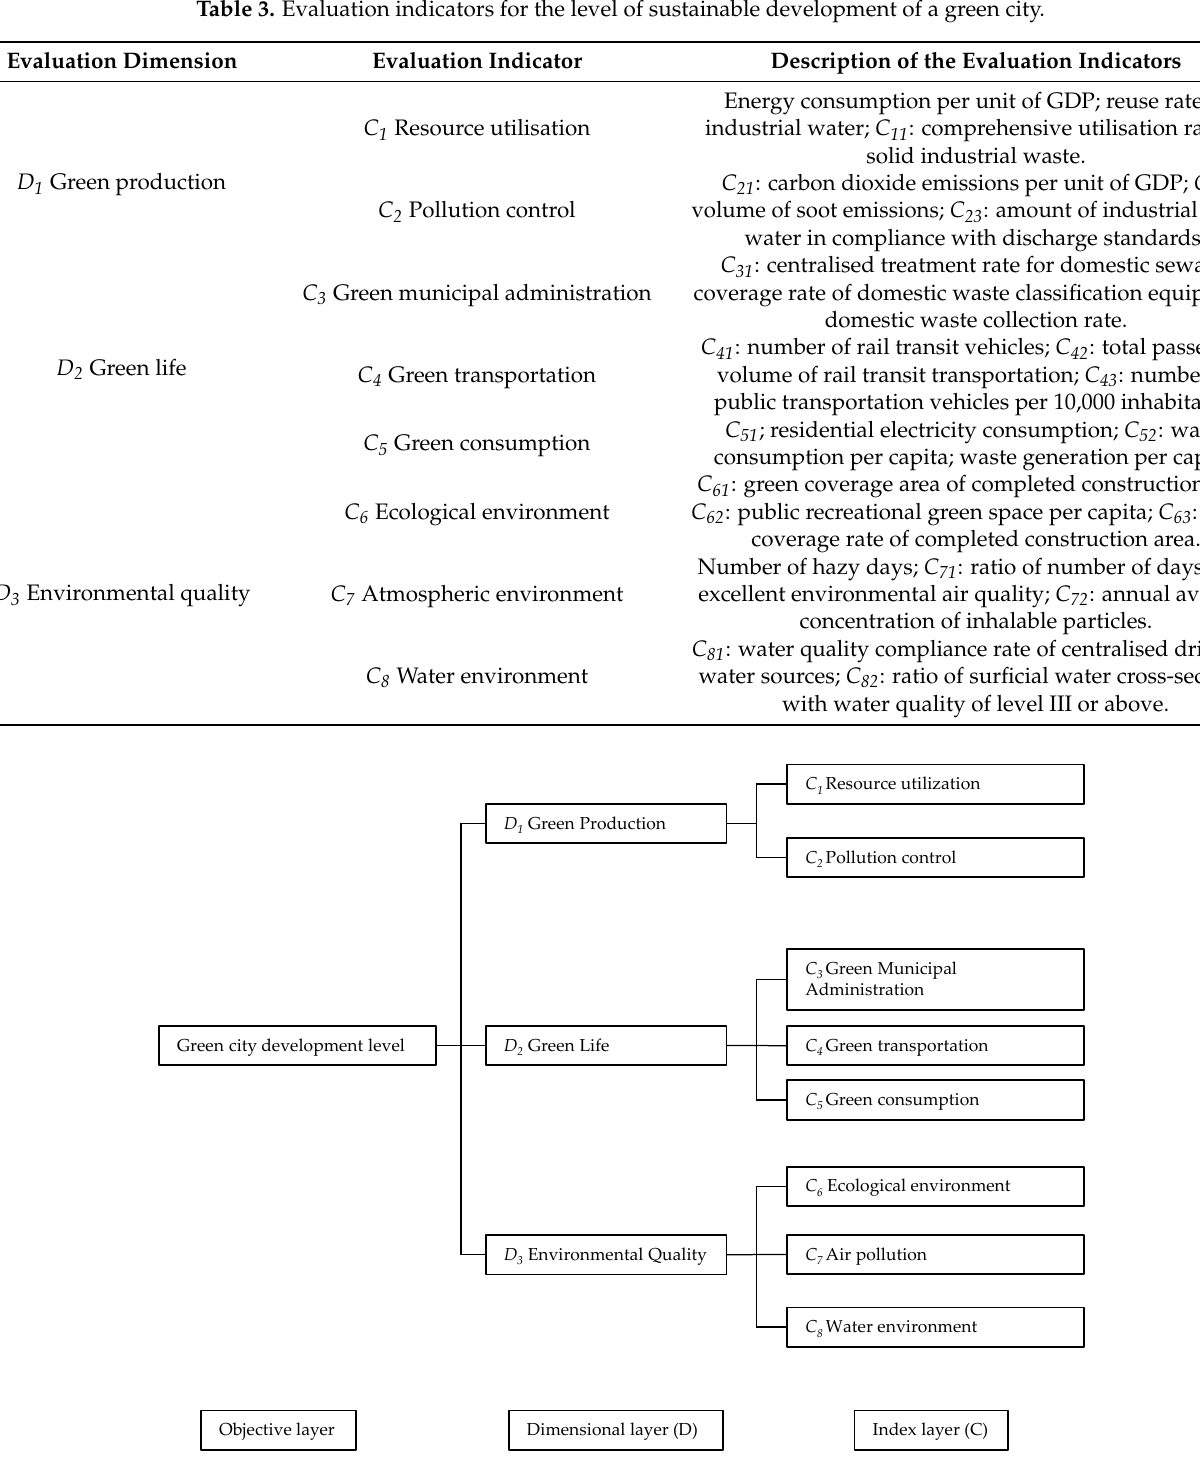
Figure 2. Framework for the indicator evaluation system for the level of sustainable development of green